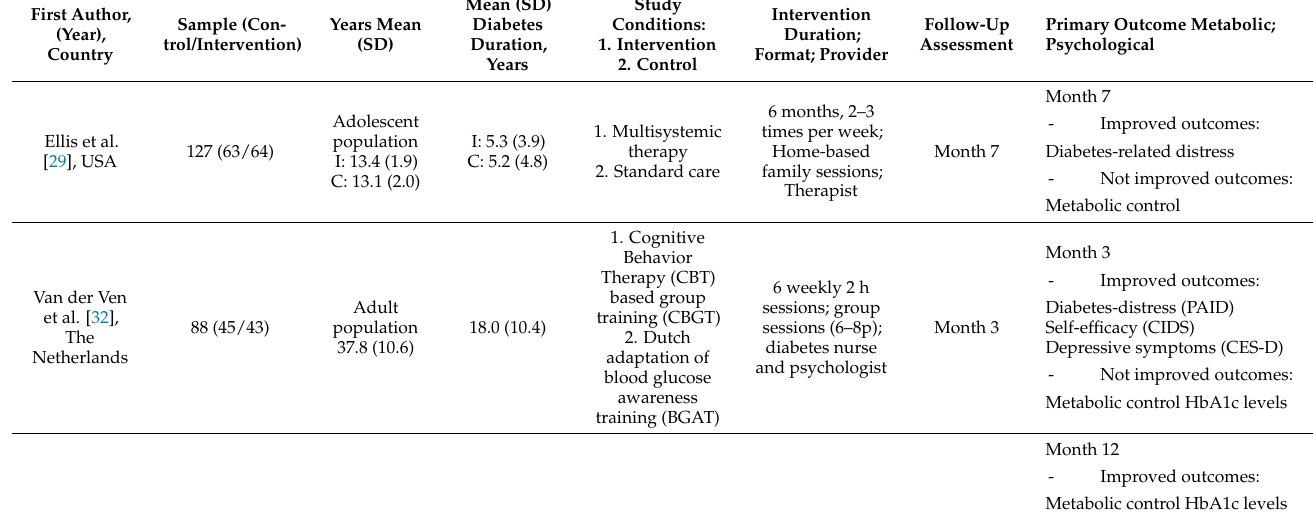
Table 2. Characteristics of studies included in the